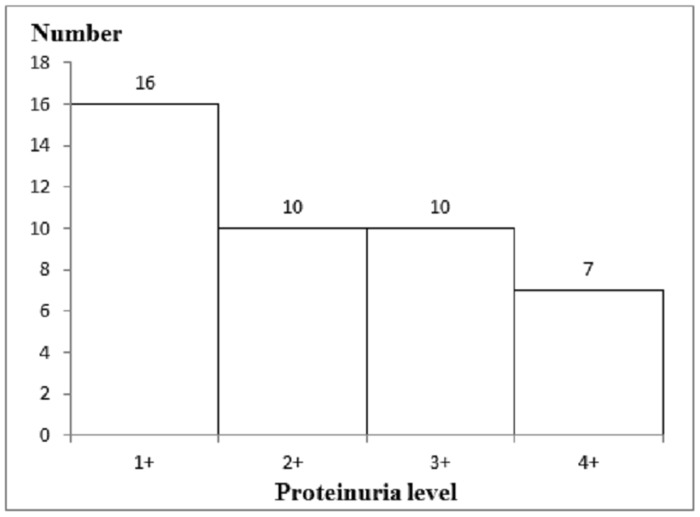
Number distribution of CKD subjects in urinalysis proteinuria levels.We further determined the number of CKD subjects according to their urinalysis proteinuria levels: 1+ (0.25g/L), 2+ (0.75g/L), 3+ (1.5g/L) and 4+ (5g/L), respectively.